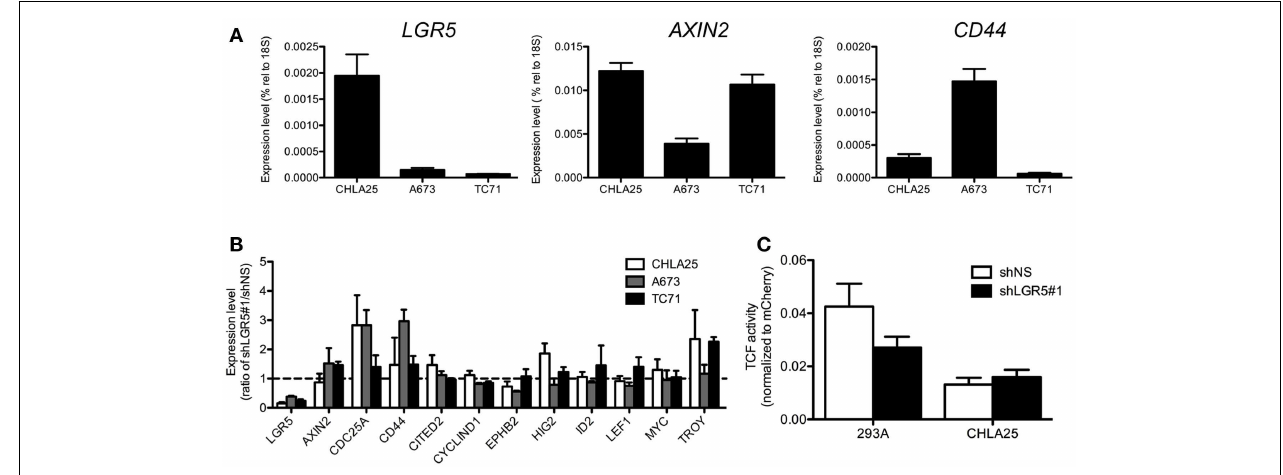
following LGR5 knockdown.The dotted line represents a ratio of 1 between shLGR5#1 and shNS cells. (C) LGR5 knockdown does not measurably decreaseWnt/ β -catenin transcriptional activity. Luciferase activity was determined usingTCF reporter-transduced cell lines as described in Section “Material and Methods.” All data shown is from three independent experiments and error bars are